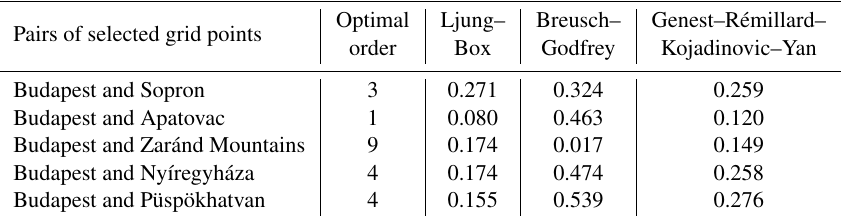
Figure 3. (a) The daily averages (annual cycle) and the smoothing loess regression; (b) the daily standard deviations (annual cycle) and the smoothing loess regression; (c) the original and the standardised data for the grid point near Budapest. Table 5. Results of tests checking for serial dependence between the estimated residuals ( p values) and the chosen order of the VAR model by Akaike